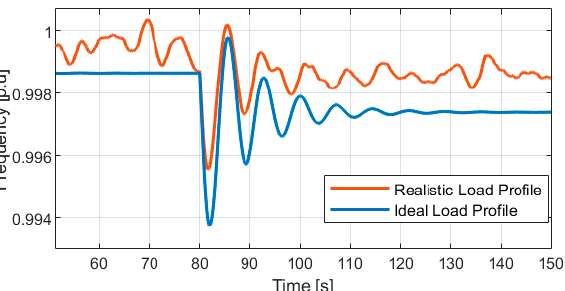
Figure 2. The average frequency of the system with different load profiles following a load step.